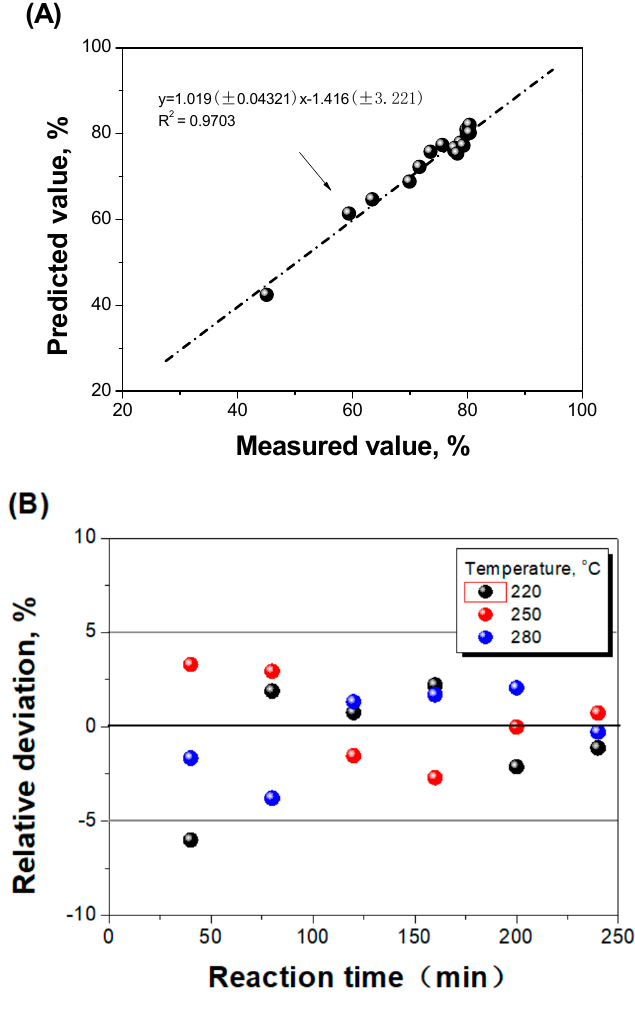
Figure 8. ( A ) The correlation between the predicted and measured data; ( B ) Relative deviation (RD) of predicted values of cyclohexanol selectivity under different temperatures.